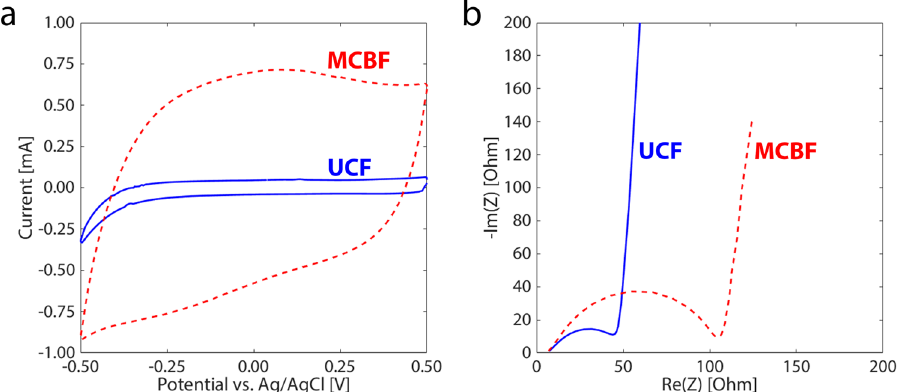
Figure 2. Electropolymerization greatly increases the specific capacitance in MCBFs relative to UCFs. ( a ) Cyclic voltammograms and ( b ) Nyquist plots measured for unmodified CF before (solid blue lines), and for MCBF after the electropolymerization process (red dashed lines).